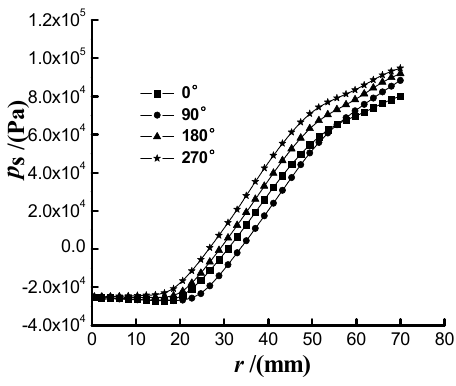
Figure 8. Static pressure distribution for the axial cross-section Z = 12.5 mm along the radial direction.